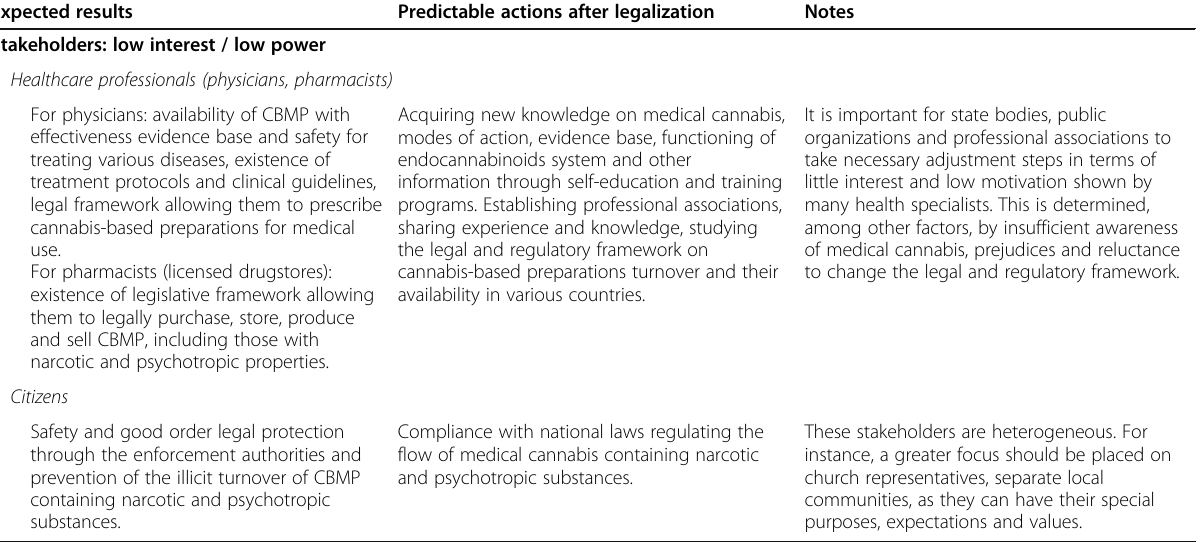
Table 2 Expectations and predictable actions of the key stakeholders in the medical cannabis market in Ukraine